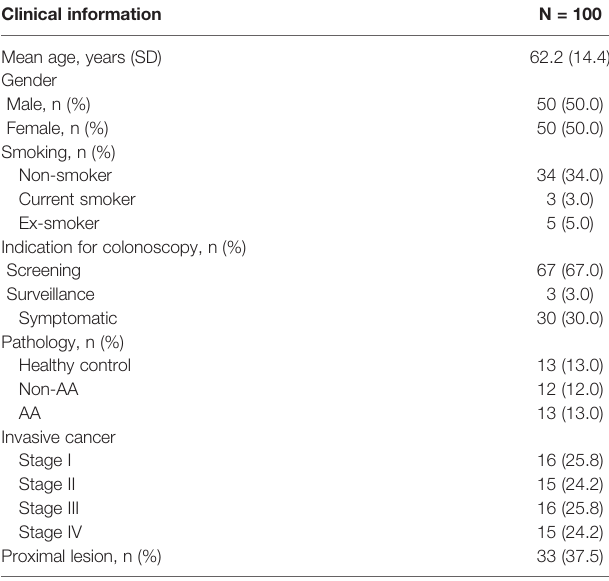
TABLE 1 | Demographics and clinical information of the study